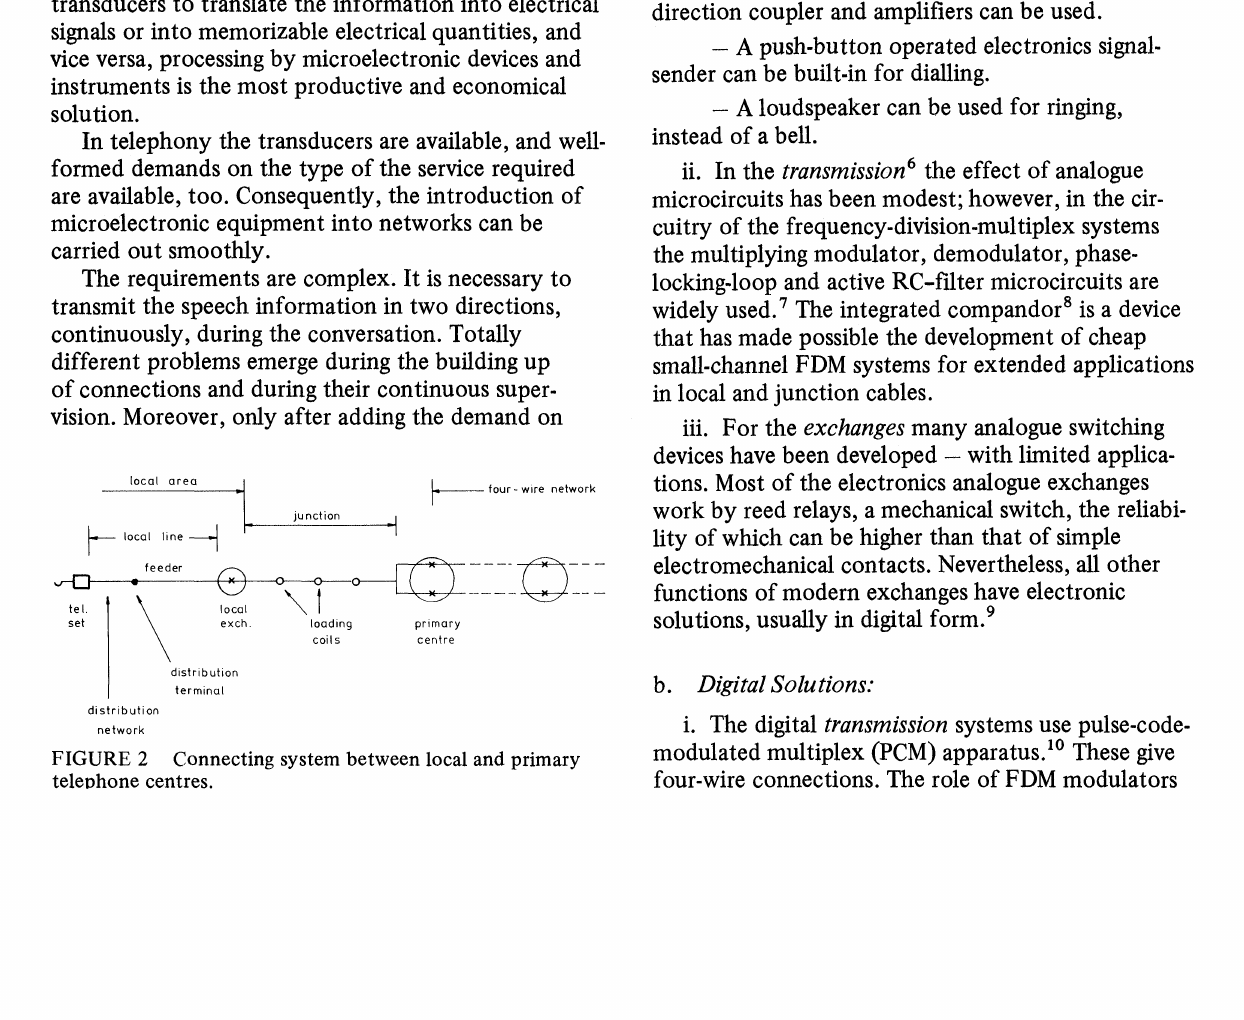
Connecting system between local and primary teleohone